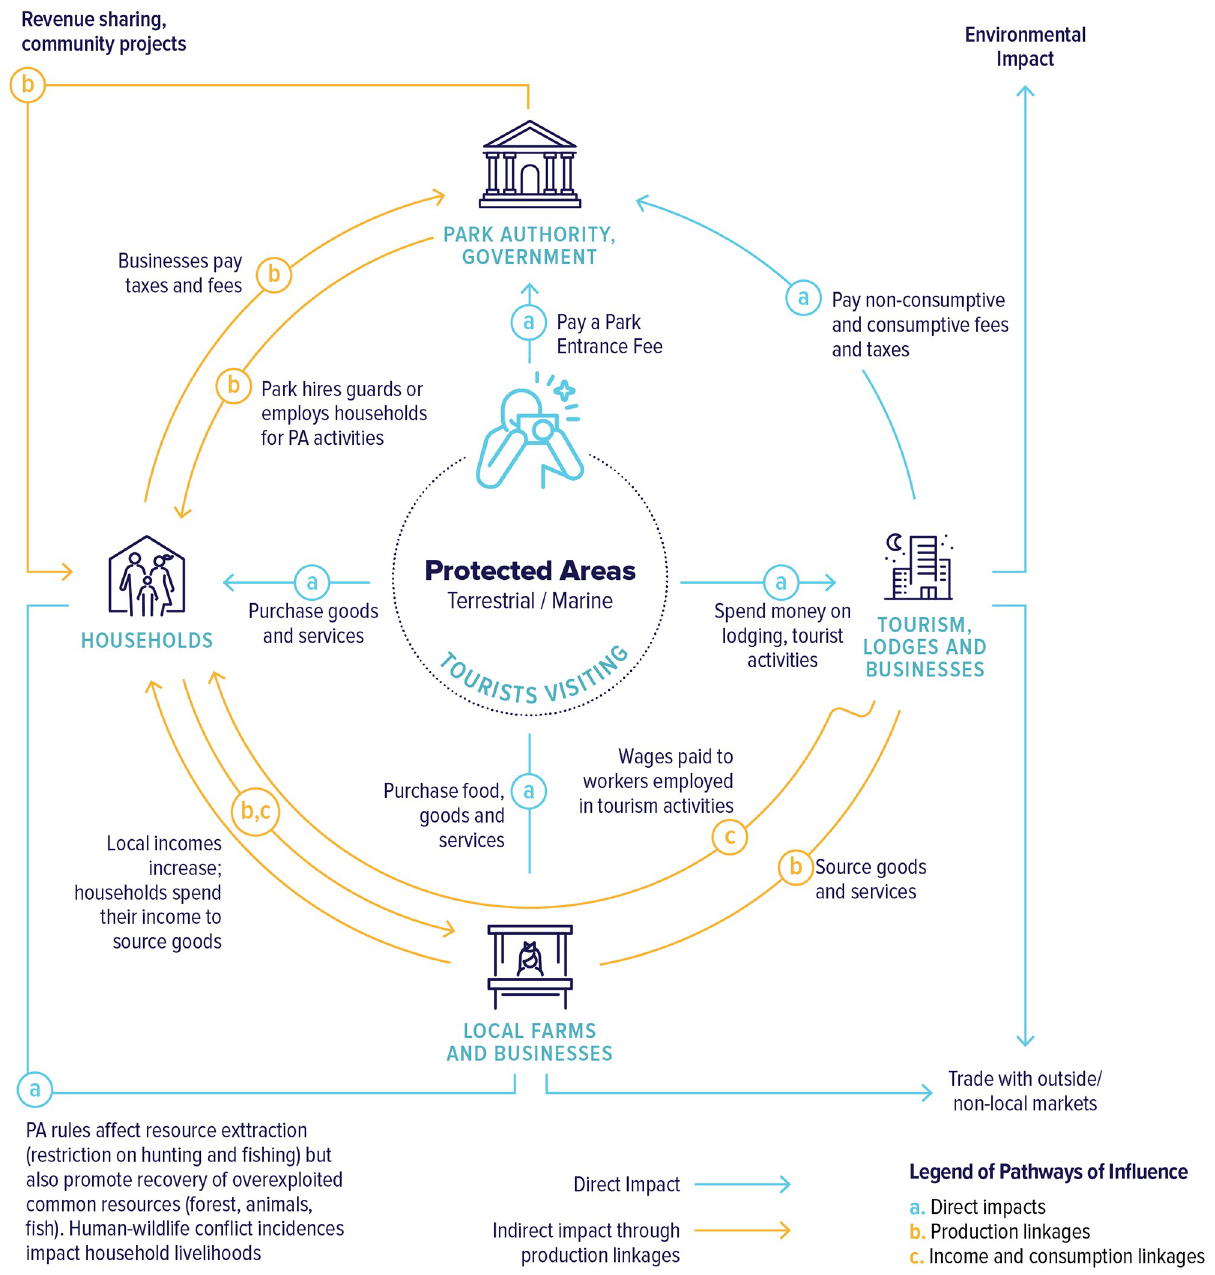
Fig 1. Economic impact pathways for protected areas. The inner channels “a” (in light blue color) show the direct impacts through tourist spending on park entrance fees, which accrue to park authorities/government; lodging and tourism activities, provided by tourism lodges and local businesses; and goods and services supplied by local households, farms, and businesses. The outer circles “b” and “c” (in orange) describe the production, income, and consumption linkages within the local economy near Protected Areas.